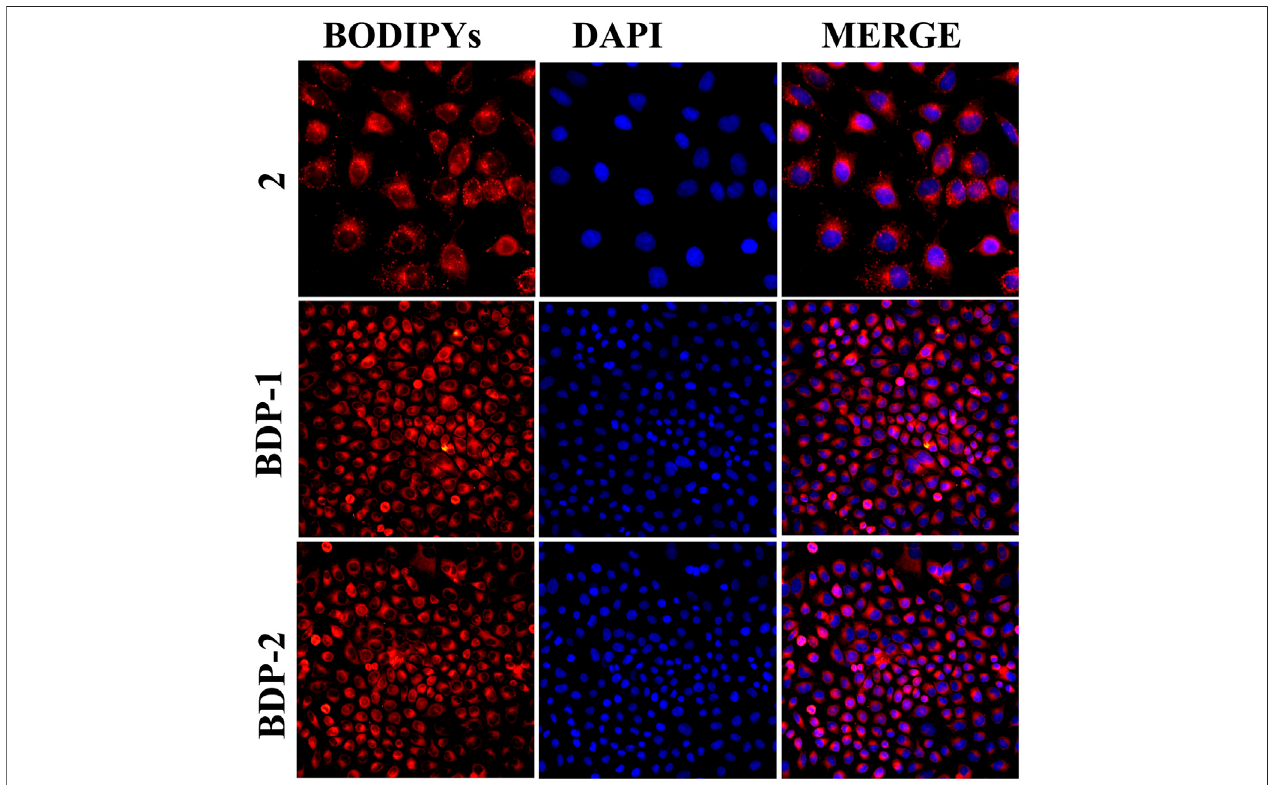
FIGURE 5 | Cell imaging stained with samples under different compounds: compound 2, BDP-1, and BDP-2 treatment.